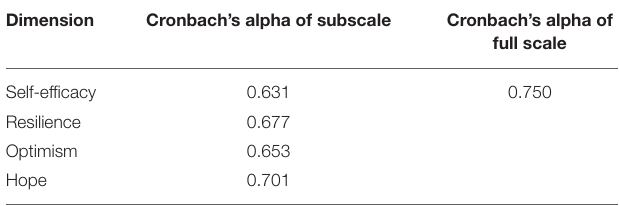
TABLE 4 | Reliability of the PsyCap scale.